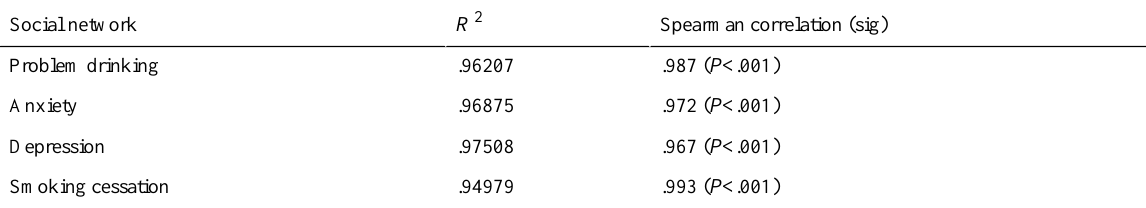
Table 3. Comparison of log-log scatter plots to power curves.